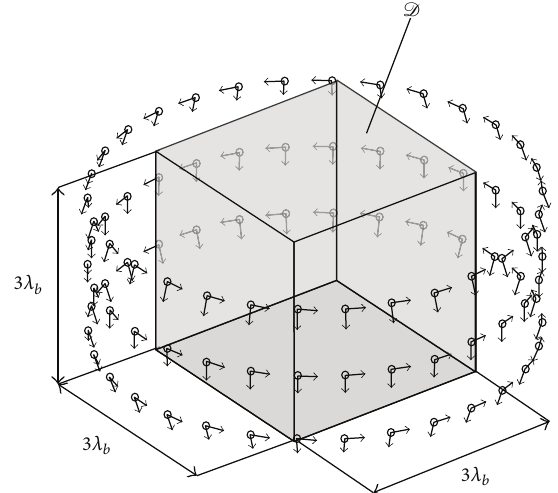
Figure 4: A view on the investigation domain D and the dipole con- figuration for the numerical adult’s arm phantom. Dipole positions are indicated with dots and orientations with arrows. All dipoles act as receivers; a subset acts as